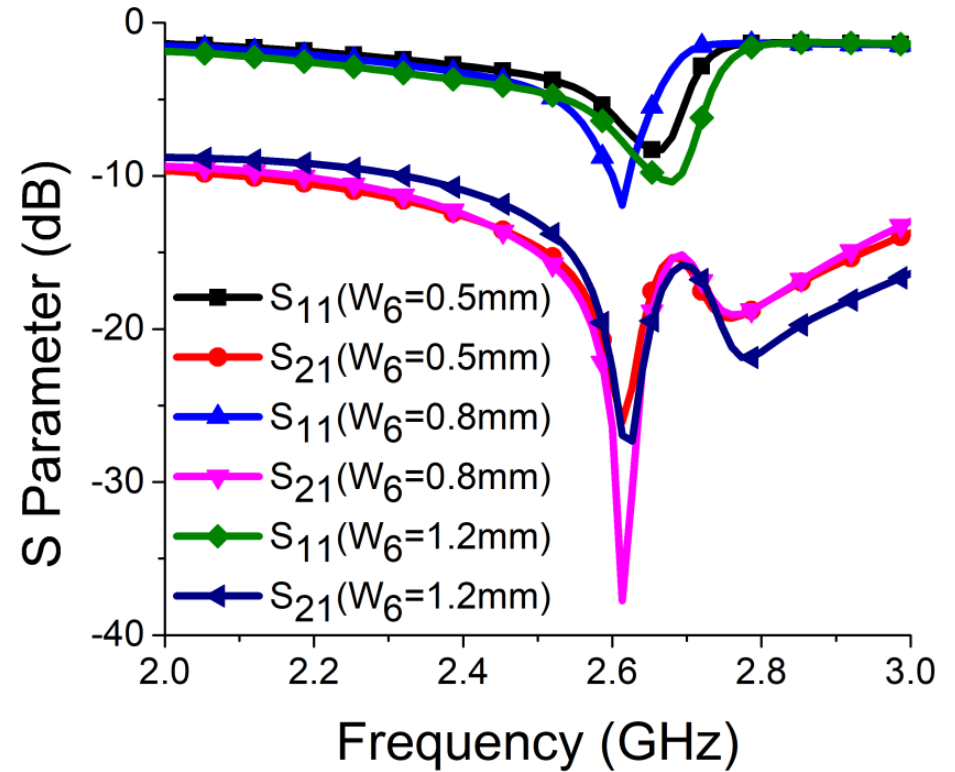
Figure 12. Effect of W 6 on resonance and isolation.